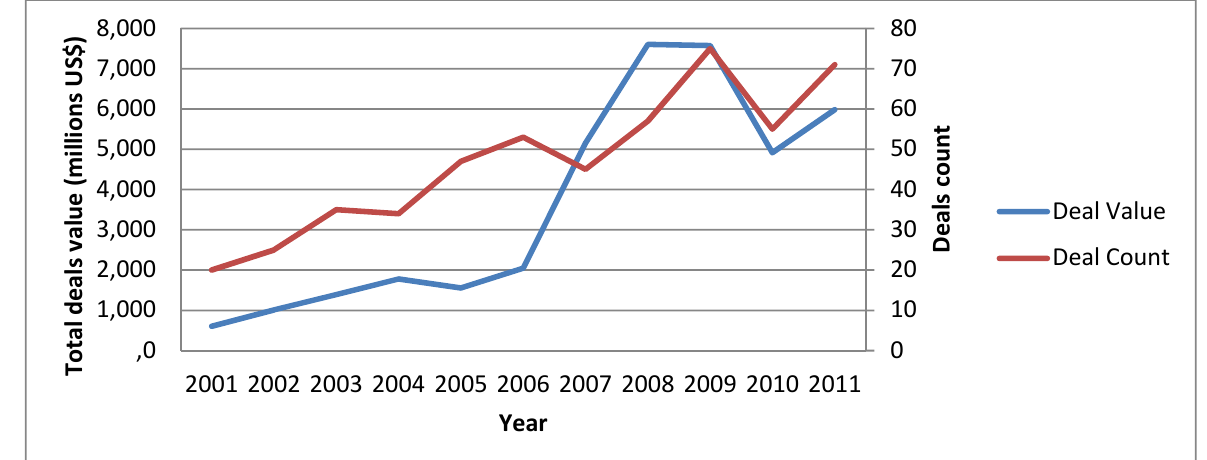
Figure 1. Mergers & Acquisition (M&A) activity in Oncology. Numbers of deals signed with molecules in Preclinical or Phase I are depicted, as well as total cumulative deals value (Source: